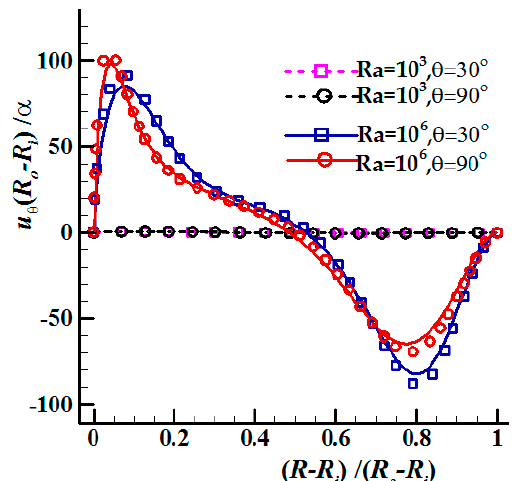
Figure 9. Variation of tangential velocity, u θ , along the gap between the inner and outer hexagonal cylinders at angular directions, θ = 30 ◦ , and θ = 90 ◦ for AR = 0.2. The symbols represent the corresponding data from Fluent software.